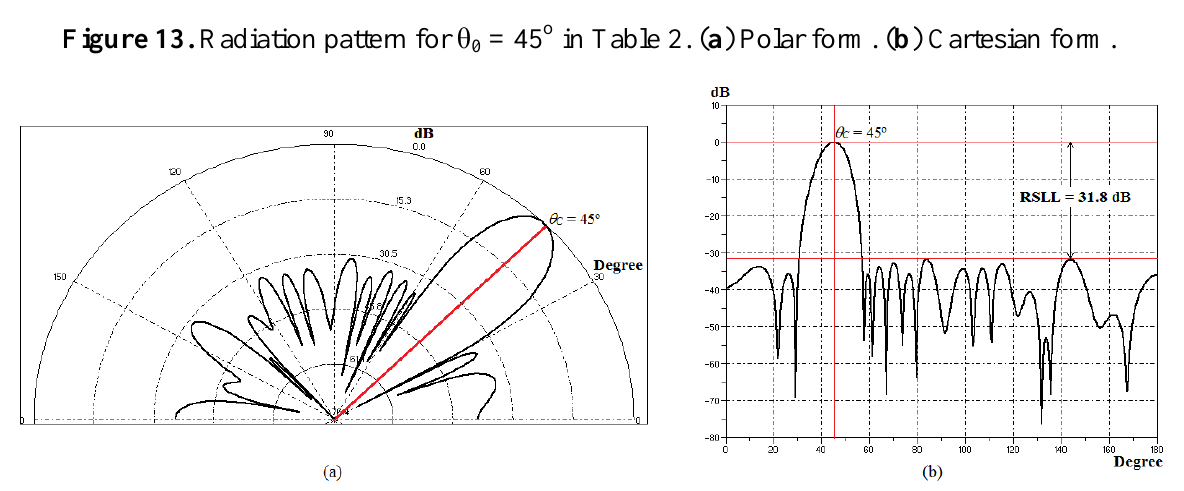
Figure 13. Radiation pattern for θ